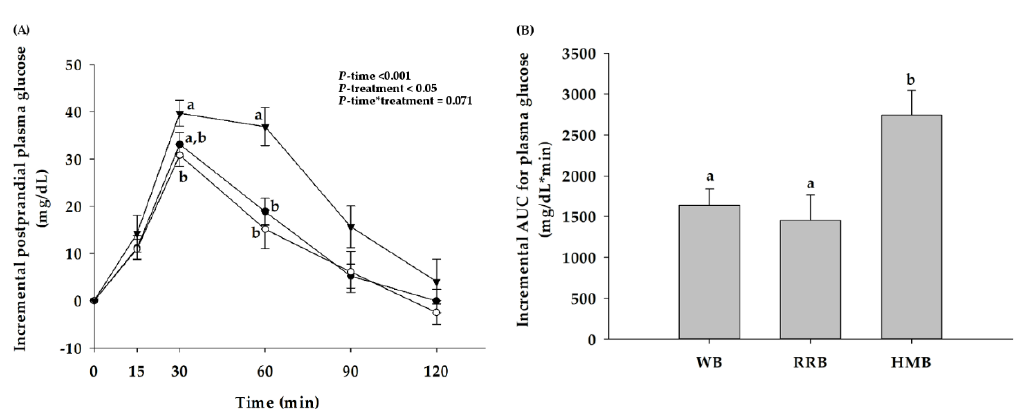
Figure 4. ( A ) Changes in postprandial glucose concentration and ( B ) the incremental area under the curves (iAUCs) for plasma glucose of healthy participants after the consumption of wheat bread (WB), Riceberry rice bread (RRB), and Hom Mali bread (HMB). All values are means ± SEM, n = 16. WB (●), RRB ( ○ ), and HMB ( ▼ ). For each time point, means with a different letter are significantly different, p < 0.05.